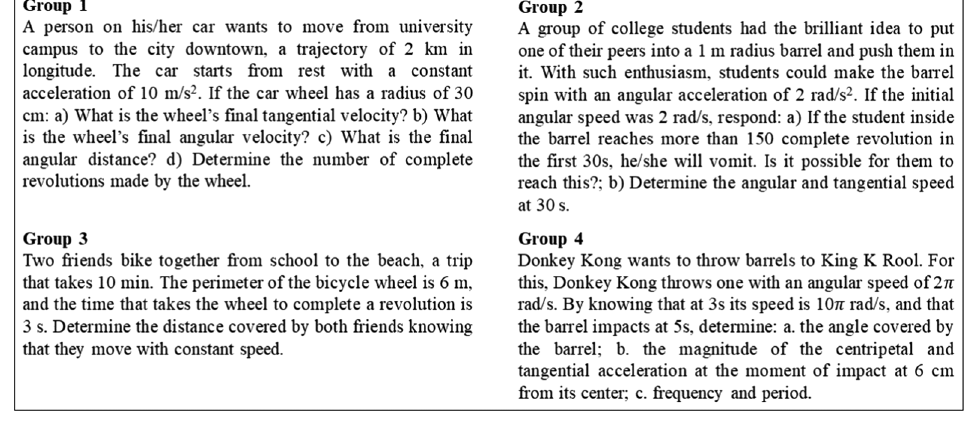
FIG. 2. Problems generated by groups 1, 2, 3, and